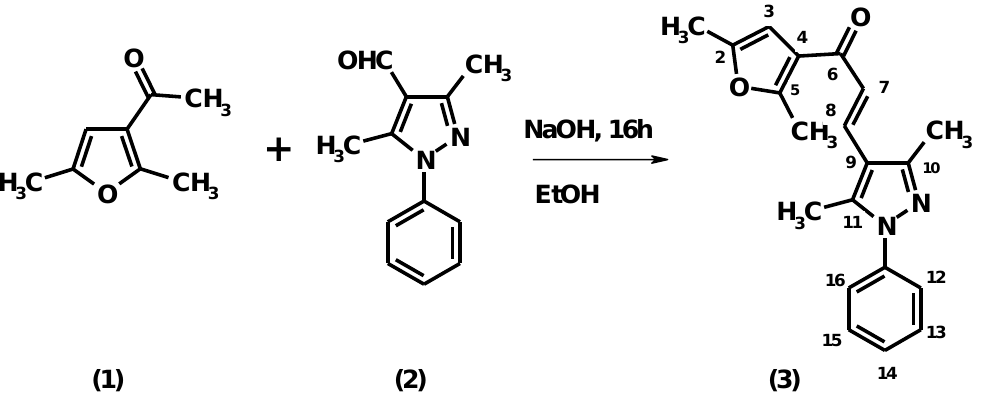
Figure 1. Synthesis of the title